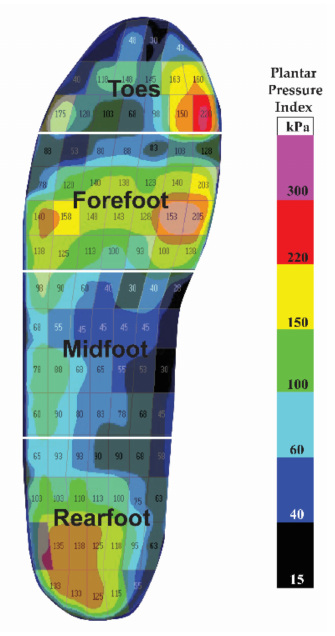
Figure 2. Four specific plantar